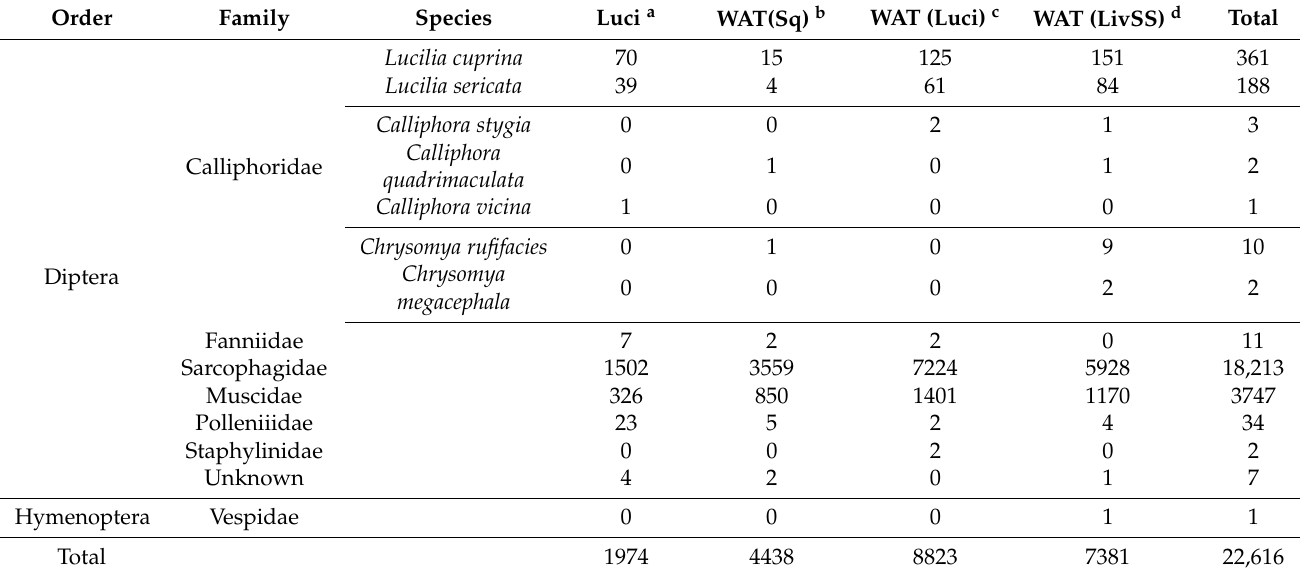
Table 2. The total number and species of flies caught over six weeks by Luci a ; WAT (Sq) b ; WAT (Luci) c ; and WAT (LivSS) d trap